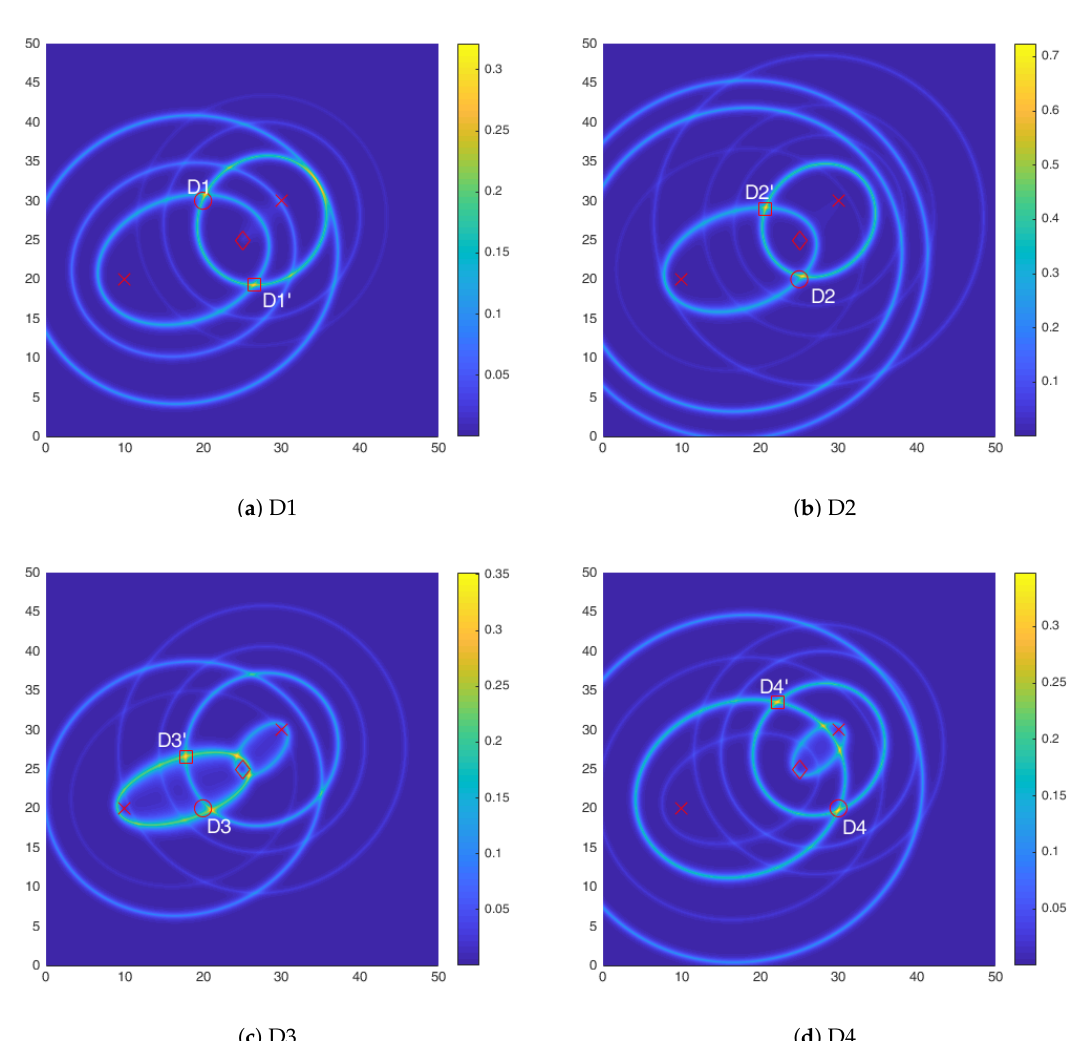
Figure 10. Hotspot identification using 2 AS pairs for all four damage scenarios. ( a ) D1; ( b ) D2; ( c ) D3; ( d )